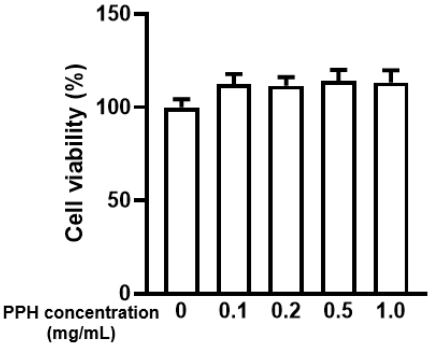
Figure 2. PPH did not show cytotoxicity in the AML-12 cells. AML-12 cells were treated with dif- ferent concentrations of PPH for 24 h. The cell viability was evaluated using the CCK-8 assay. Data are expressed as mean ± SEM of 5 independent experiments.